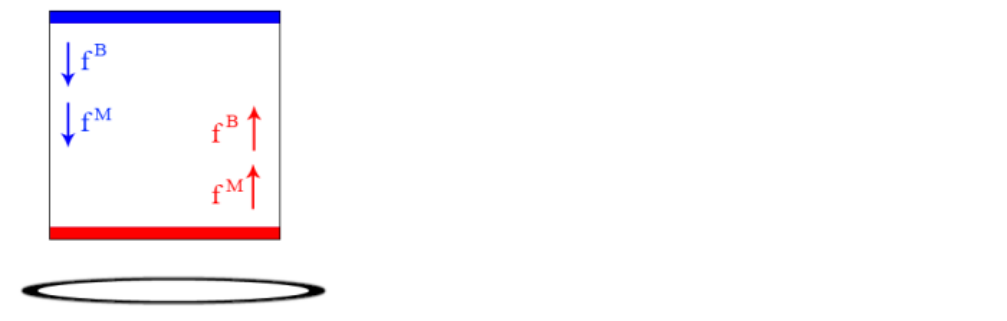
Figure 1. A schematic view of the buoyancy and magnetic forces acting on a fluid in the present research.